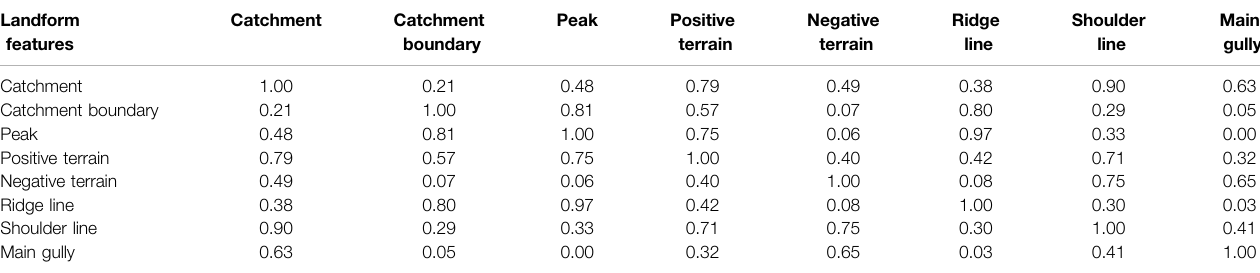
TABLE 4 | R 2 of the hypsometric integral (HI) of each landform feature. Landform features